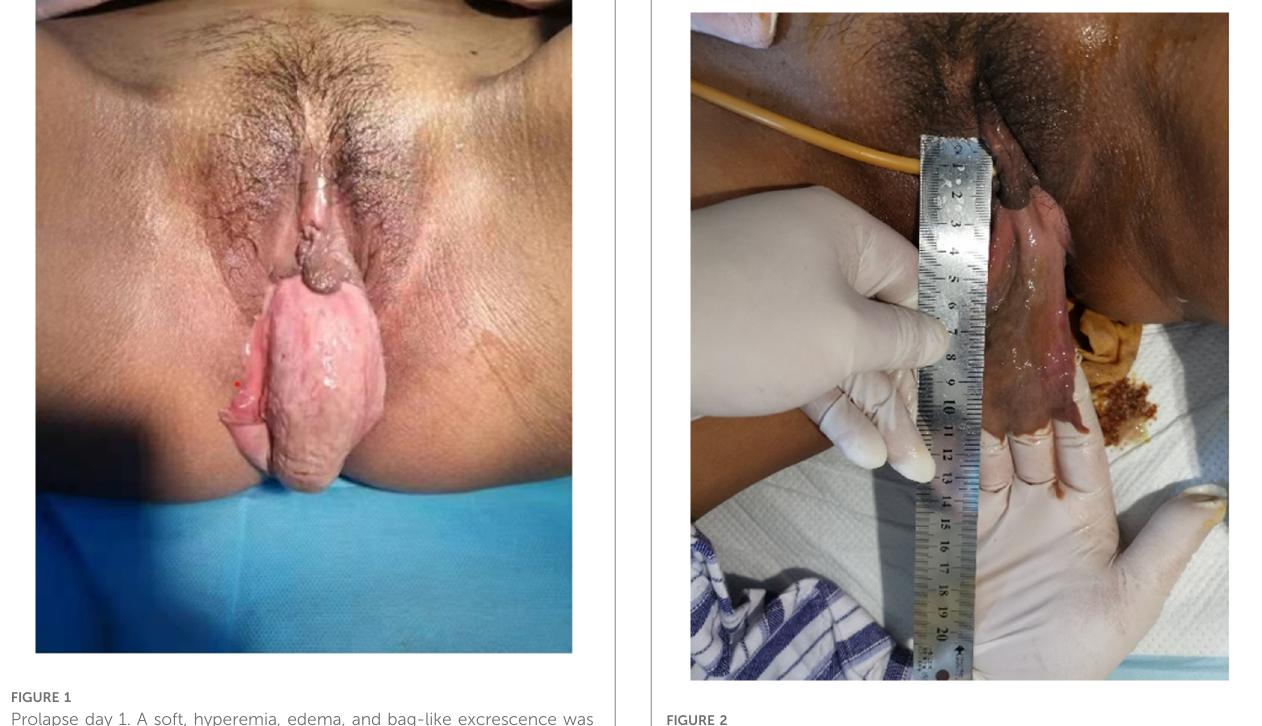
FIGURE 2 Prolapse day 5. The mass became fl aky and gradually darkened due to